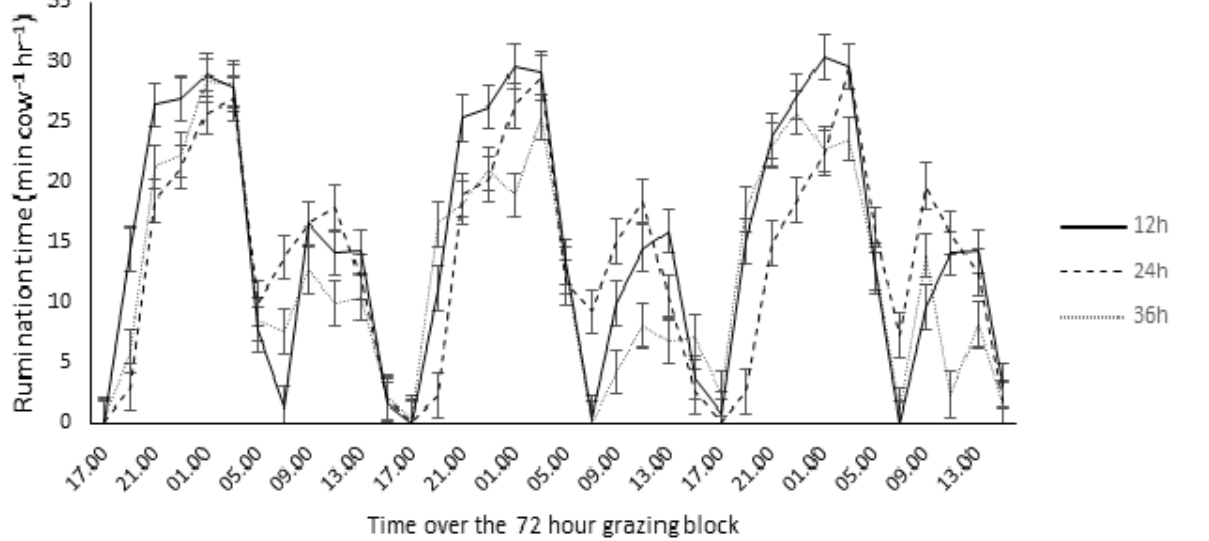
Figure 2. Ruminating time of primiparous animals offered fresh pasture every 12, 24 and 36 h over a 72 h grazing block.